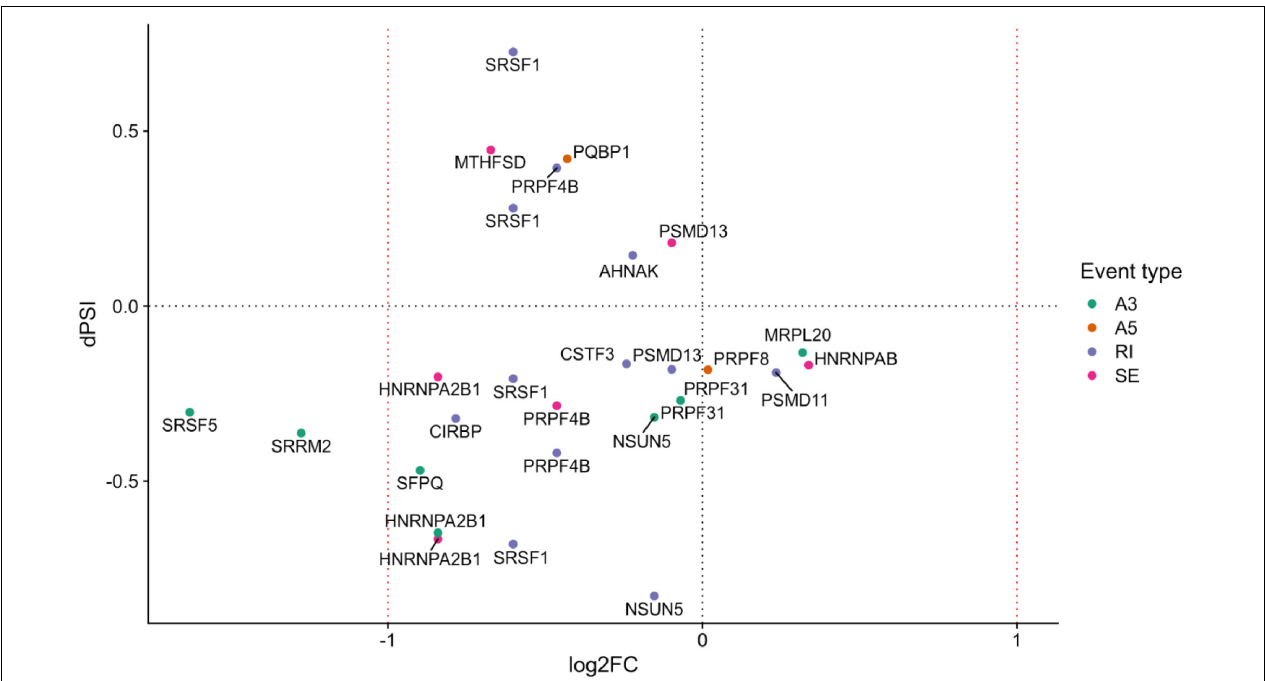
FIGURE 5 | Splicing-related genes with at least one differentially spliced event ( p value < 0.05) in the Control-RPE vs. Patient-RPE contrast (only genes unique to the RPE contrast are considered). Each event is colored by type (A3, alternative 3 (cid:48) site; A5, alternative 5 (cid:48) site; RI, retained intron; SE, skipped exon). dPSI is shown in the y -axis (dPSI < 0: event inclusion favored in control, bottom panel; dPSI > 0: event inclusion favored in patient, upper panel). log2(Fold Change) is shown in the x -axis (FC < 0: gene downregulated in patient, left panel; FC > 0: gene upregulated in patient, right